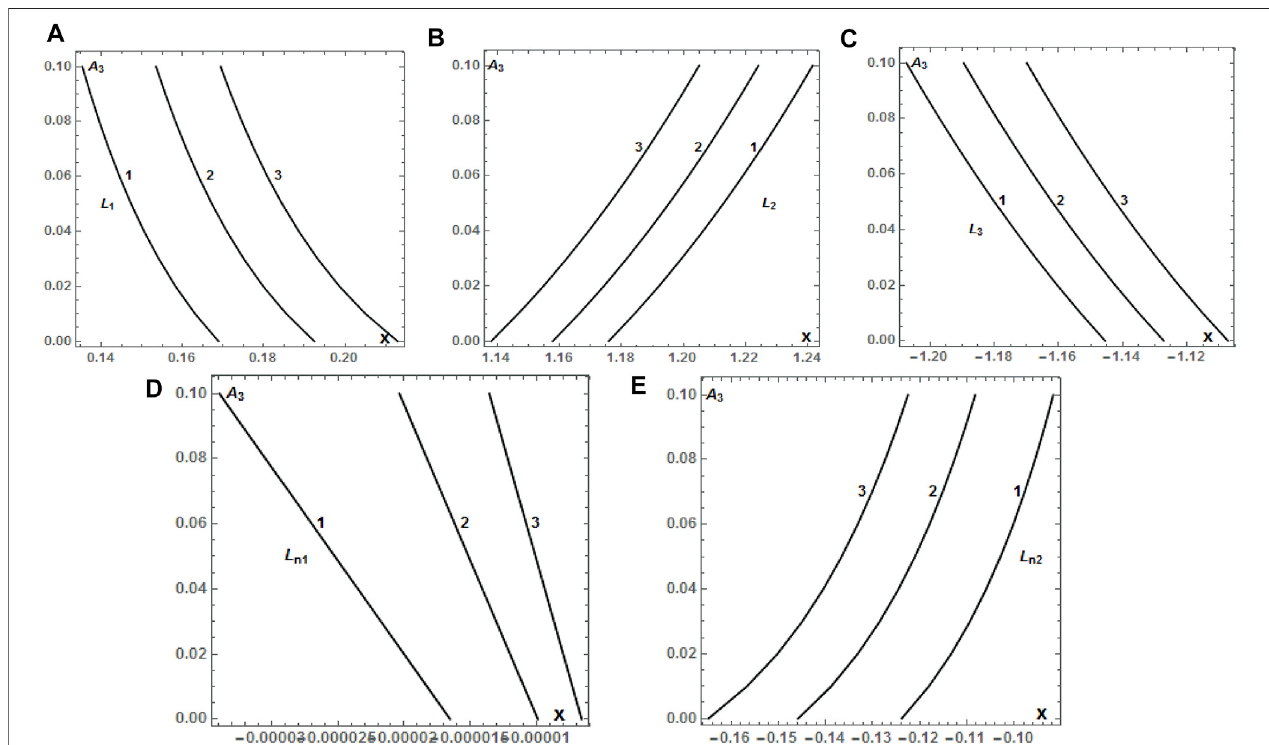
FIGURE 9 | (A – E) Positions of the collinear equilibrium points L i , i = 1, 2, 3, L nj , j = 1, 2, of the HD155876 system, as a function of A 3 , which varies in the interval (0, 0.1] for fi xed values of M b equal to 0.06 (1), 0.1 (2), and 0.15 (3), respectively. The radiation pressure and triaxiality parameters are kept as constants as in the previous case (Table 6) . The numbering of equilibrium points is according to the diagram shown in Figure 2 .